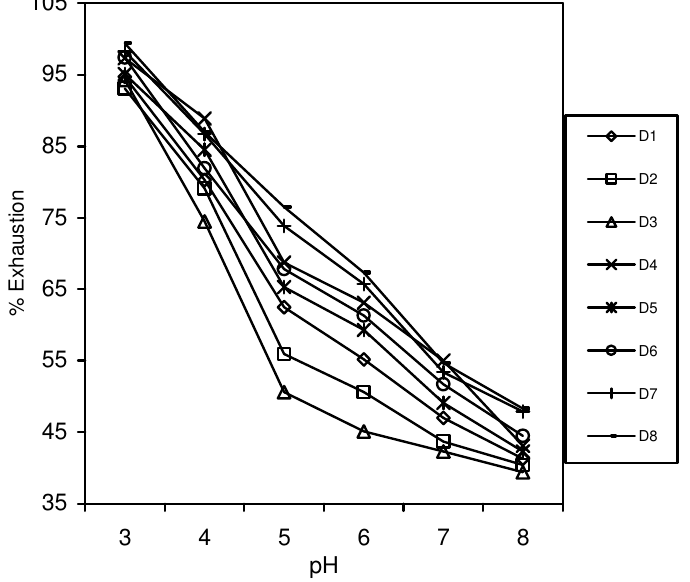
Figure 5. Effect of application pH on exhaustion